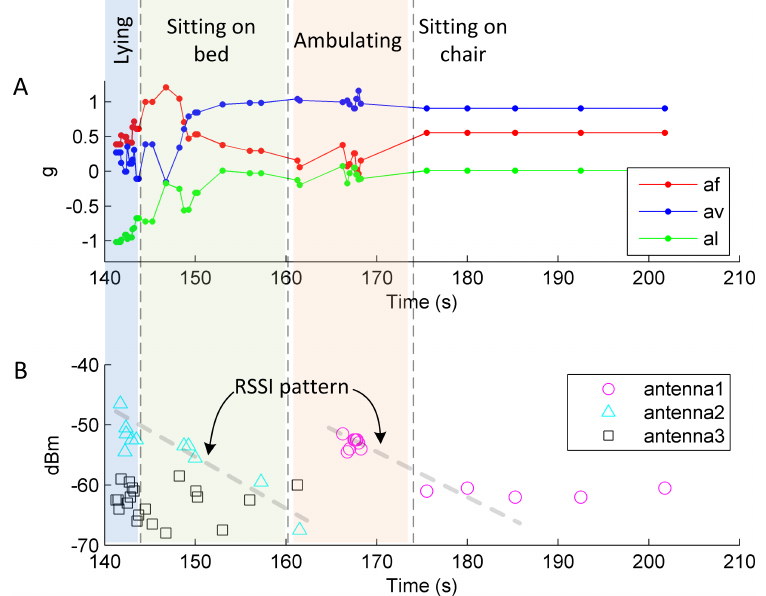
Figure 5. Sample of collected sensor data. ( A ) Raw accelerometer readings along the three axes; and ( B ) RSSI (received signal strength indicator) received from three antennas in the room and RSSI pattern changes across four